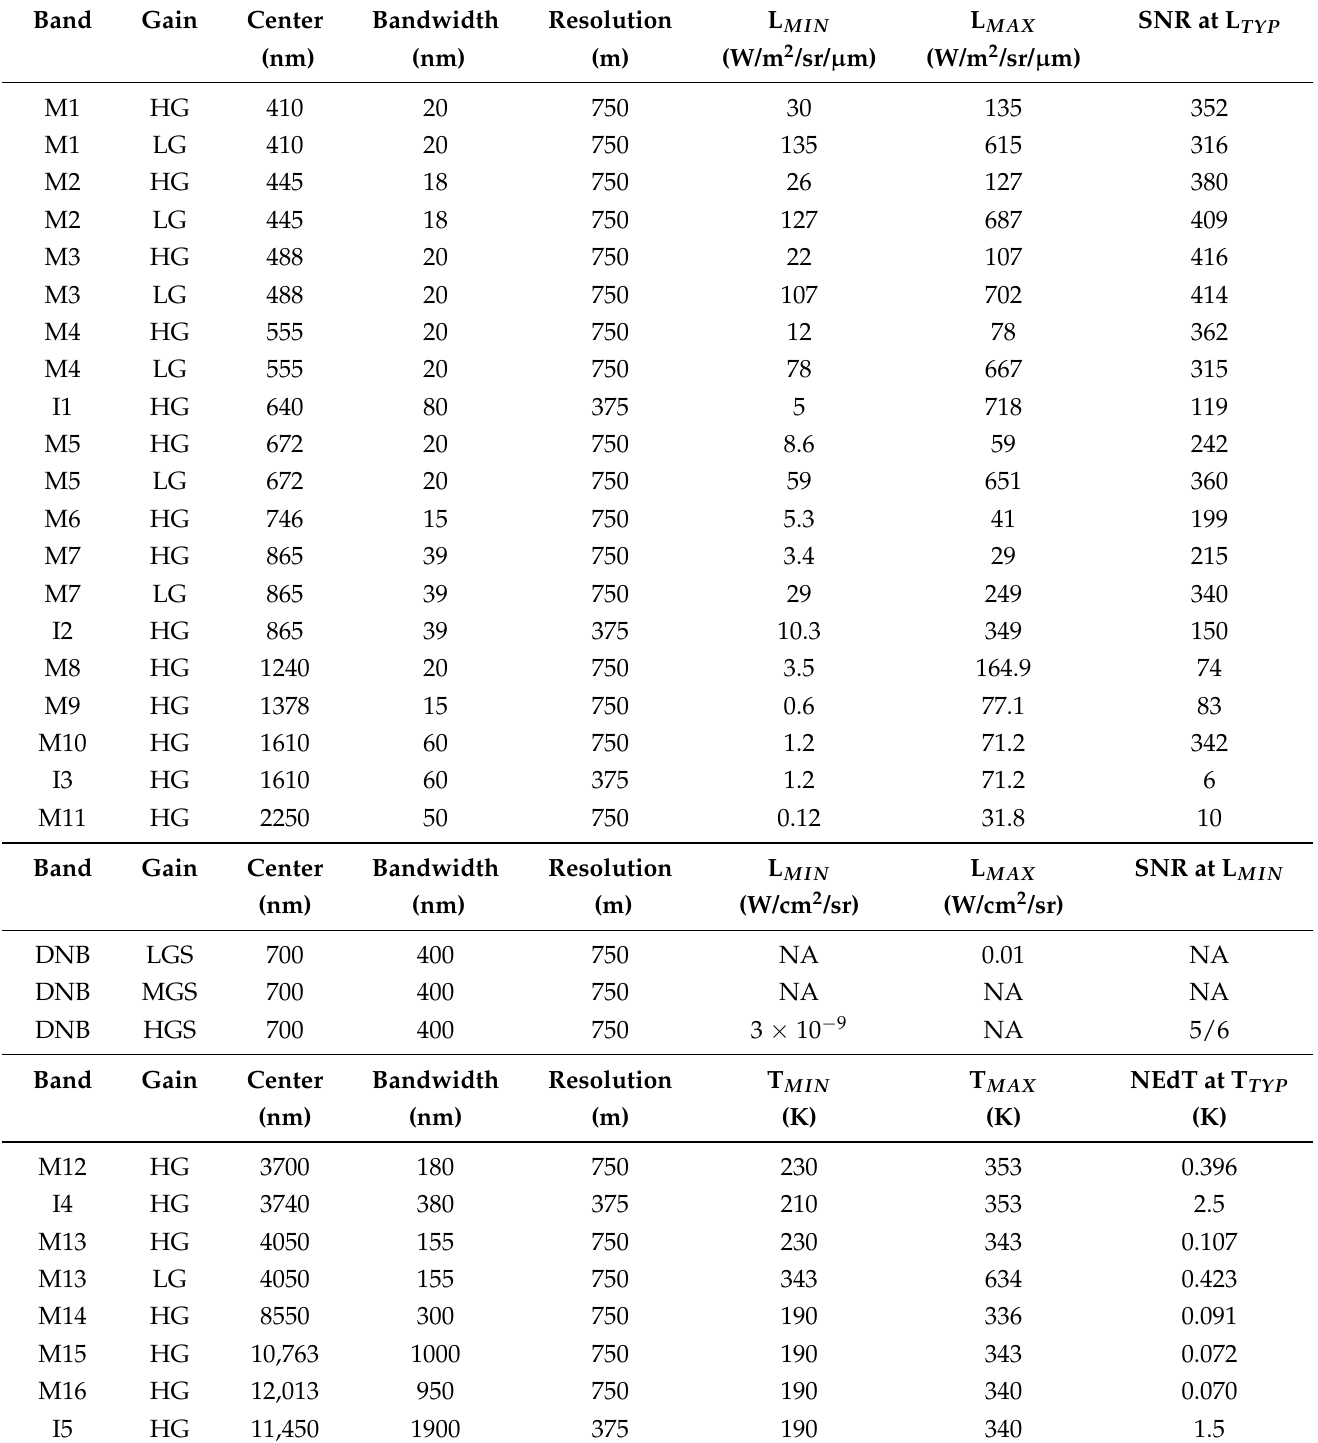
Table 1. JPSS-3 VIIRS bands characteristics from the sensor specification [10]. HG and LG refer to high and low gain for the dual gain